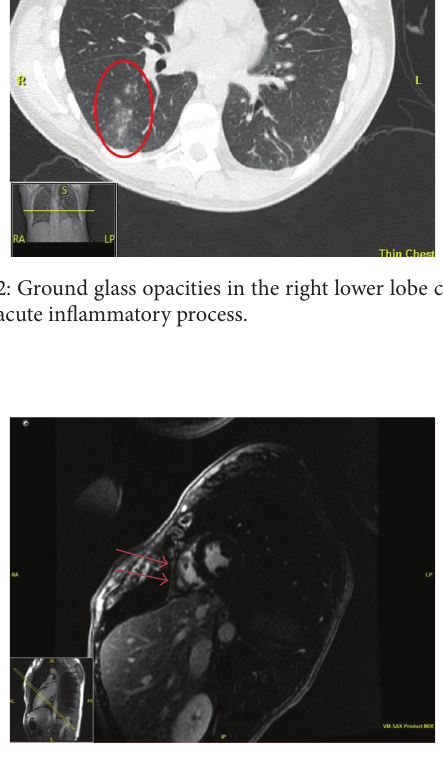
Figure 3: Pericardial enhancement of the right ventricular free wall on cardiac MRI consistent with acute